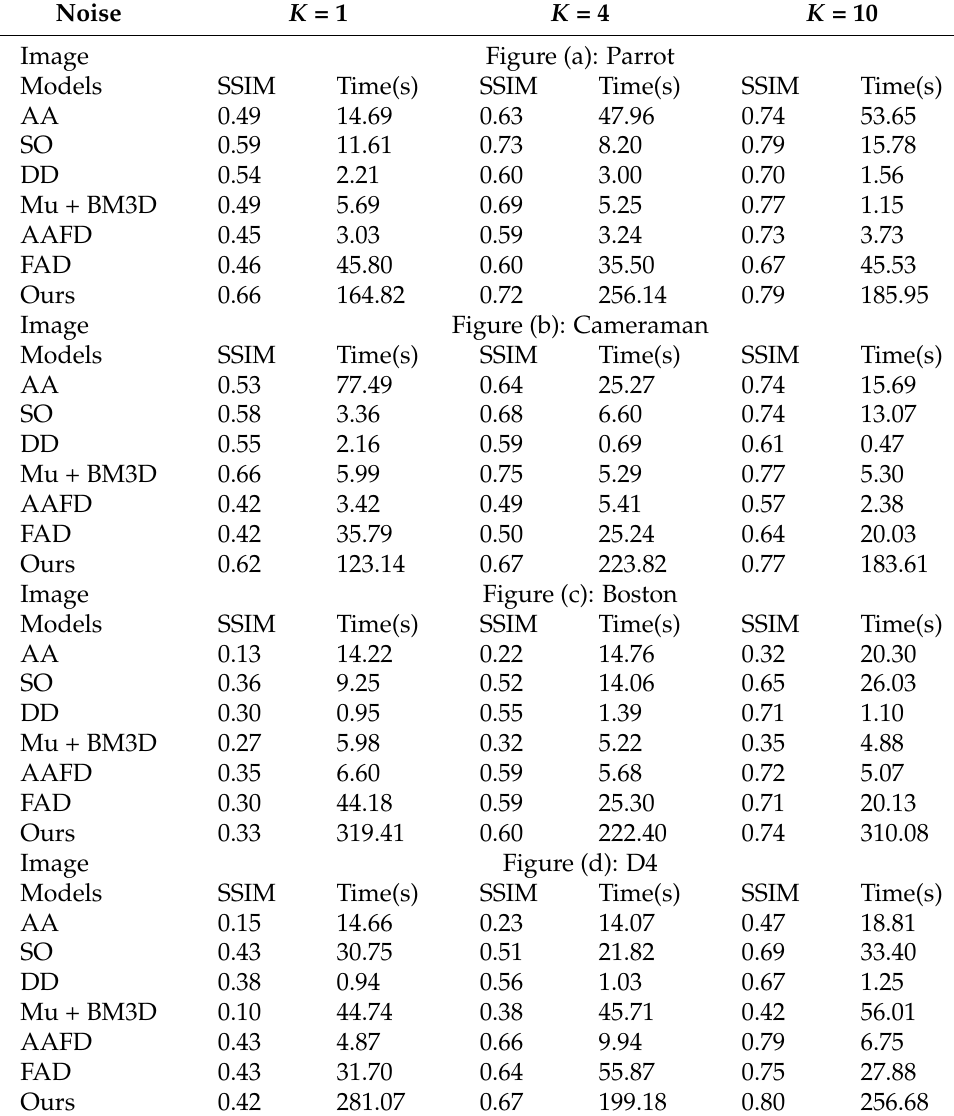
Table 3. Comparisons of SSIM and CPU Times by using different denoising